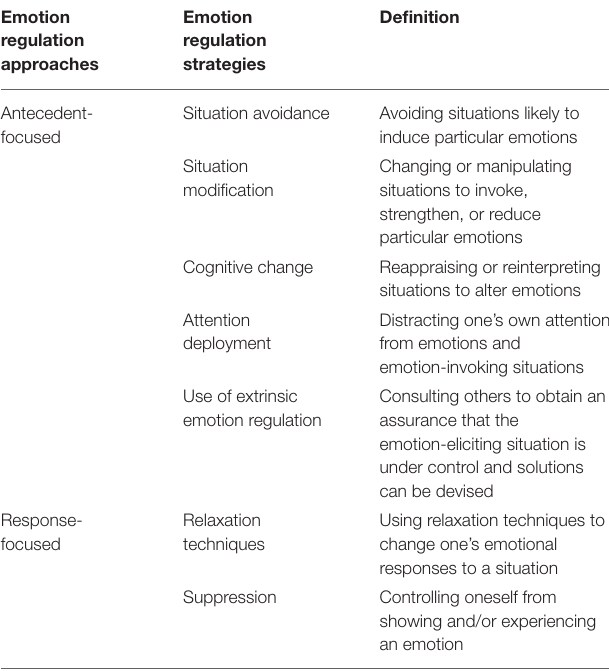
TABLE 1 | Approaches and strategies of intrinsic emotion regulation adapted from Gross (1998, 2015) and Zaki and Williams (2013). Emotion